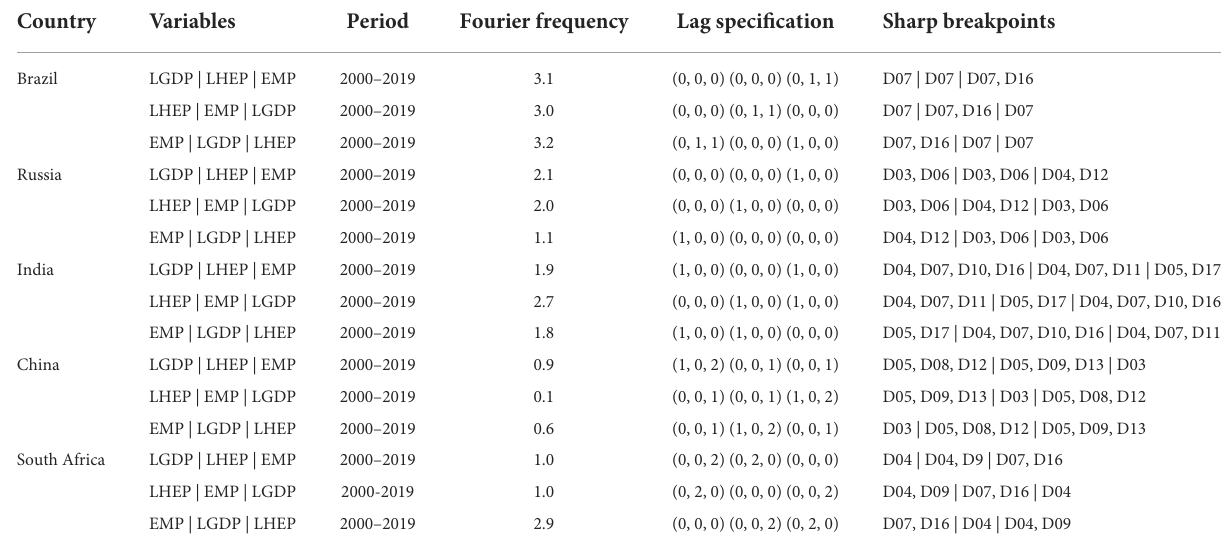
TABLE 5 Fourier frequency and sharp breakpoints. Country Variables